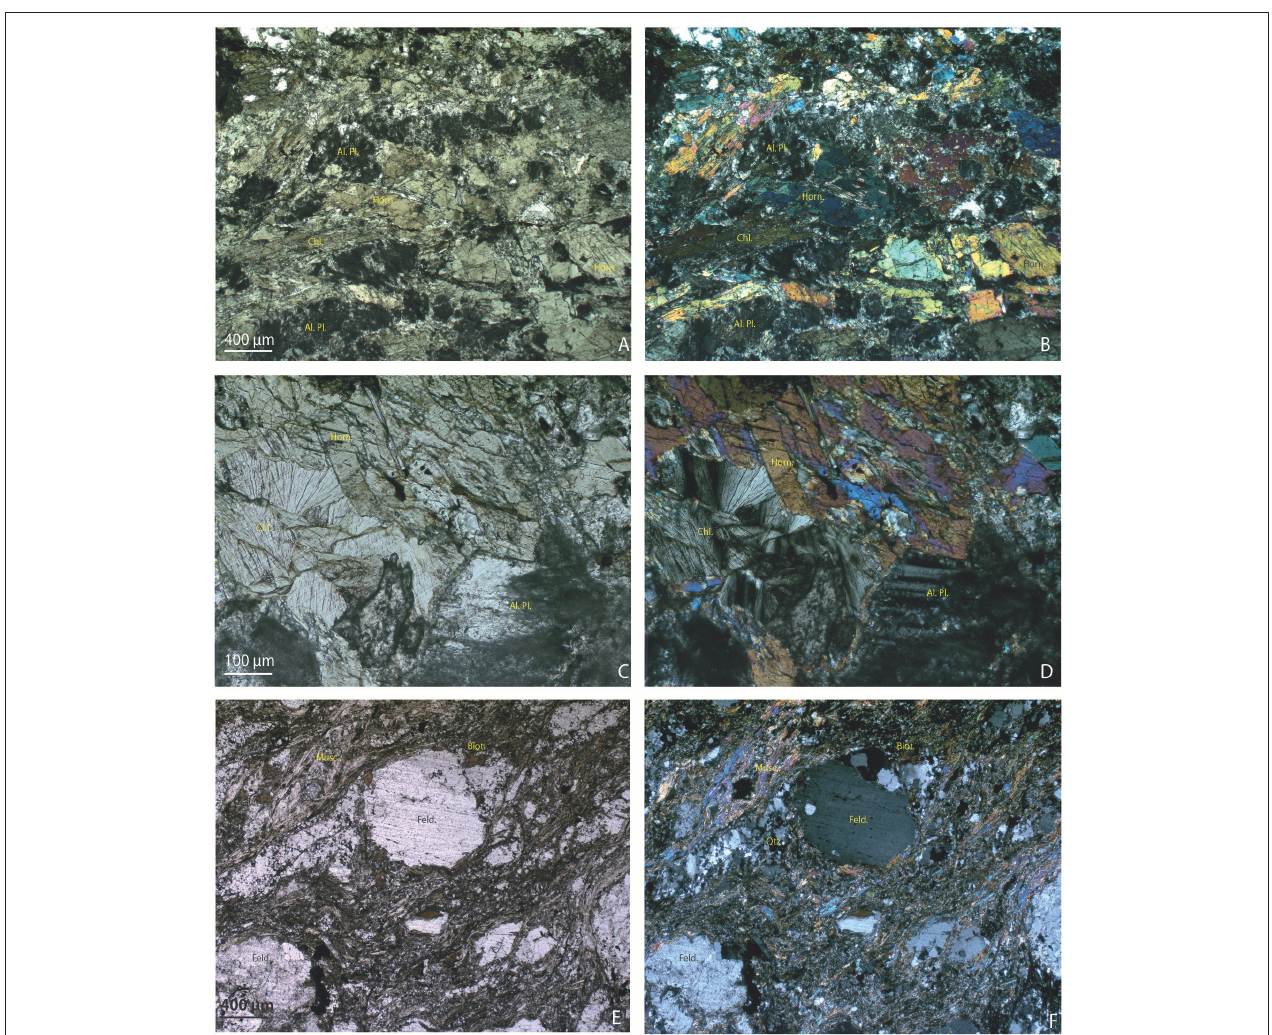
FIGURE 7 | Thin sections of the Bossons bedrock samples under a microscope. (A) amphibolite BOS2-1C showing altered plagioclase (Al. Pl.), green hornblende (Horn.), and abundant chlorite; (B) the same view under polarized light; (C) details of the same sample BOS2-1C showing altered hornblende partially replaced by chlorite and altered feldspars (plagioclase with typical polysynthetic twinning observed under polarized light); (D) the same view under polarized light; (E) thin sections of coarse-grained “augen” gneiss BOS2-1D show characteristic shearing structure with elliptic feldspar porphyroclasts (Feld.) within the layerings of the quartz (Qtz), biotite (Biot.), and muscovite (Musc.) bands; (F) the same view under polarized